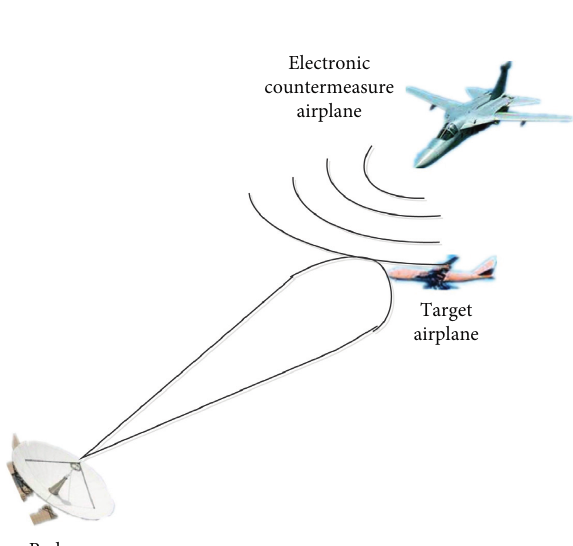
Figure 1: Radar interfered by active